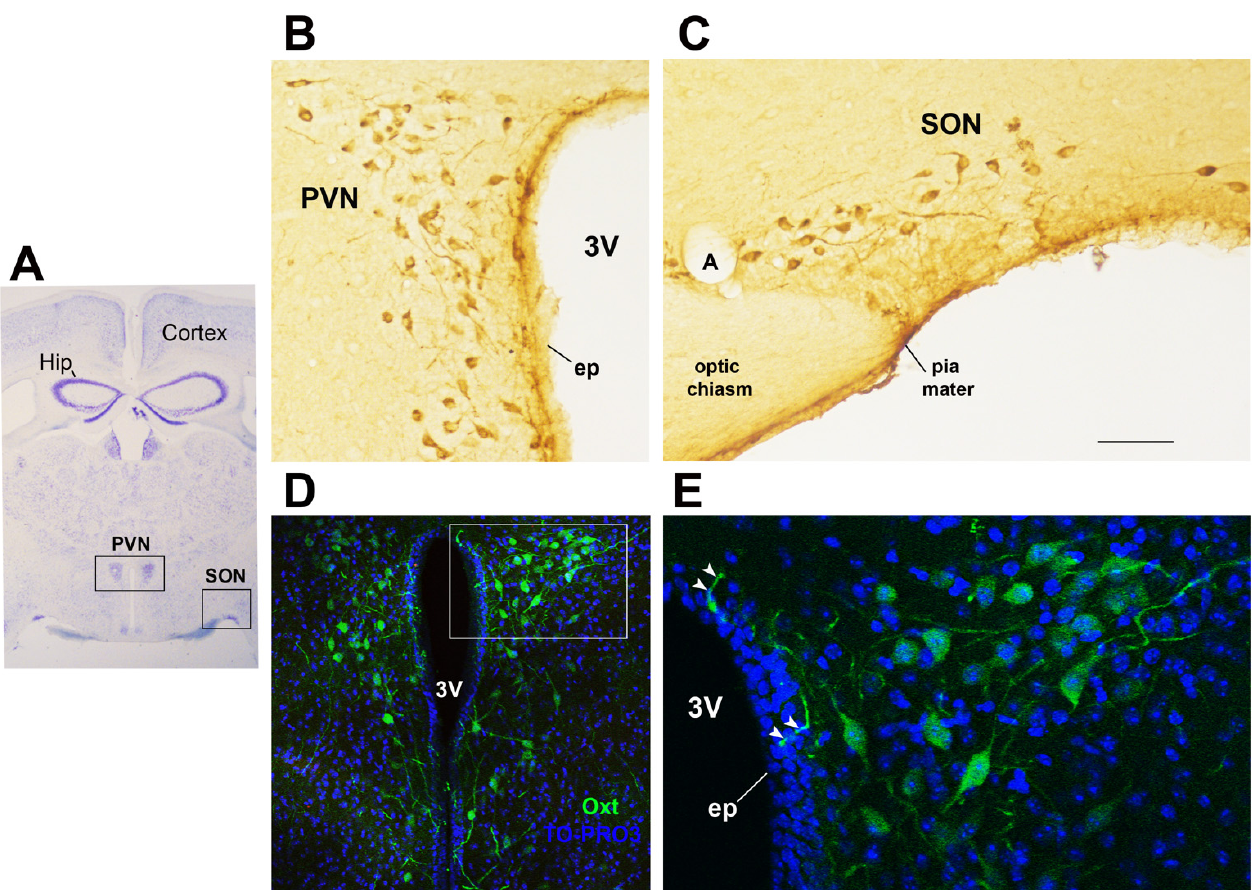
Figure 1. Oxytocinergic neurons in the paraventricular (PVN) and supraoptic (SON) hypothalamic nuclei. ( A ) Light microscopy (LM): Nissl-stained brain coronal section of the region corresponding to bregma − 0.94 mm; PVN: hypothalamic paraventricular nucleus; SON: hypothalamic supraoptic nucleus; Hip: hippocampus. ( B ) LM: peroxidase immunohistochemistry of oxytocin (Oxt)-positive neurons in proximity of the ependymal layer (ep) of the third ventricle (3 V) in the PVN. ( C ) Peroxidase immunohistochemistry of Oxt neurons in the SON; A: artery. ( D ) Double-label confocal microscopy of Oxt neurons (green) and cell nuclei (blue TO-PRO3 staining) in the PVN. Panel ( E ) is an enlargement of the area framed in ( D ), showing Oxt-positive neurons and their projections (arrowheads) reaching and contacting the ependymal cells and the cerebrospinal fluid of the third ventricle (3 V). All figures refer to a 6-month-old male C57BL/6 mouse. Bregma reference sections from “The Mouse Brain Atlas”, Paxinos and Franklin (2001). The scale bar is included in C only and corresponds to different µ m in each figure as follows: in ( A ): 1500 µ m; in ( B , C ): 45 µ m; in ( D ): 120 µ m; in ( E ): 40 µ m. All figures are original. Methodological details are available in the Supplementary Materials S1.